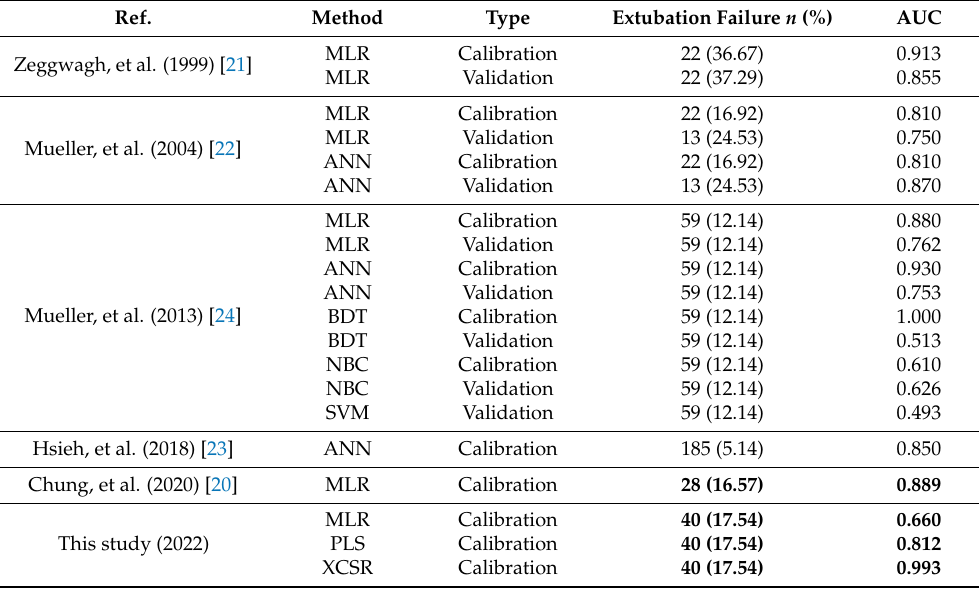
Table 7. AUC results of the current and previous studies (bold text: the result of our group).